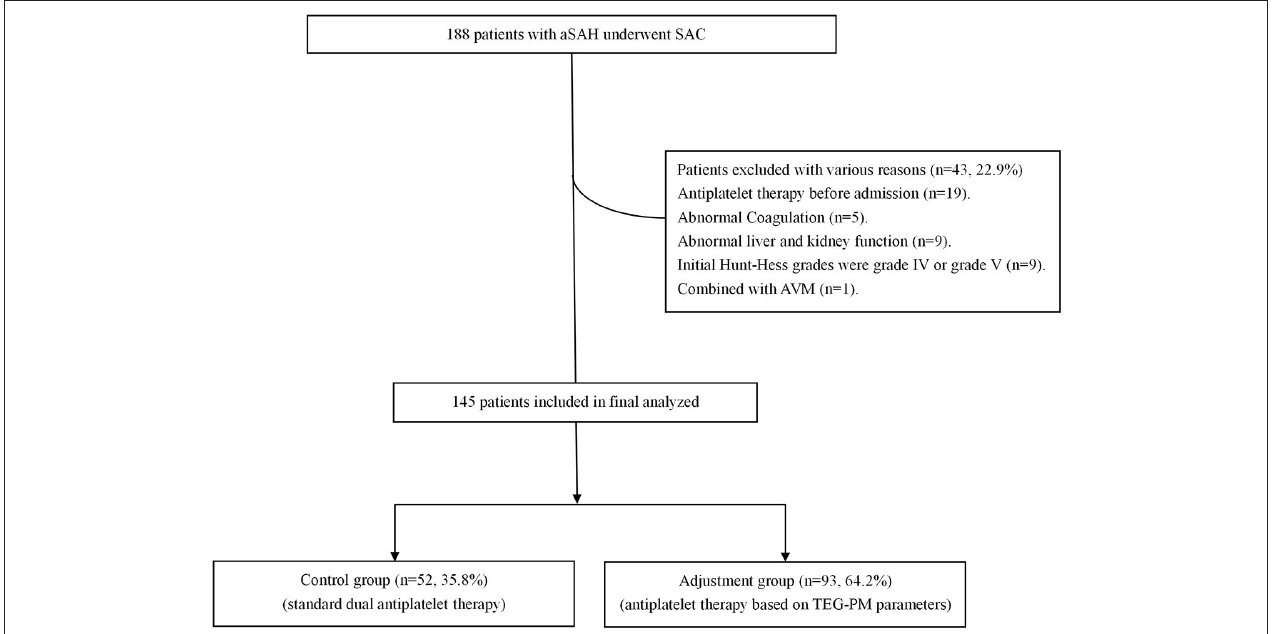
FIGURE 1 | Abbreviated flowchart for patients included in this study based on the inclusion and exclusion criteria. aSAH, aneurysmal subarachnoid hemorrhage; SAC, stent-assisted coiling; AVM, arteriovenous malformations.